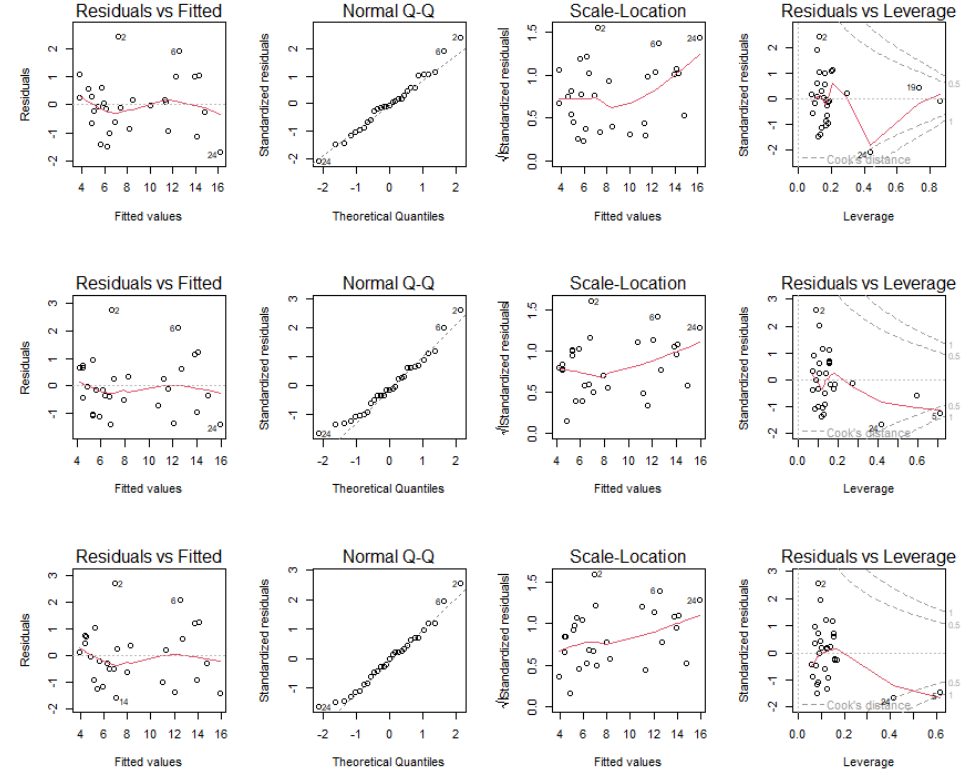
Figure A1. Goodness − of − fit of the chest press 1 − RM equation models.